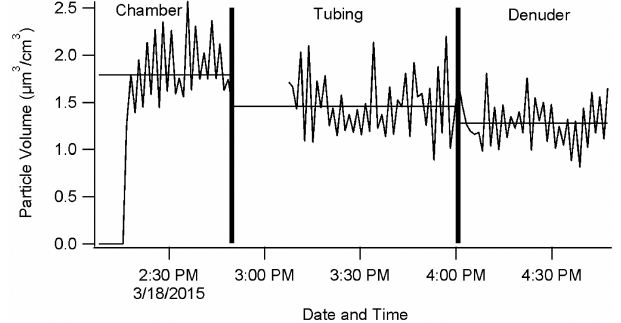
Figure 7. SEMS-measured particle volume vs. time to test denuder efficiency. From 02:15 (local time) to 03:00 the SEMS was measur- ing directly from the chamber. From 03:00 to 04:00 the SEMS was measuring particles from the TD-CRDS tubing (only internal tub- ing to the inlet system) without the denuder. From 04:00 to 05:00 the SEMS measured through the TD-CRDS tubing and the denuder. The horizontal lines represent the average particle volume over the sampling period. The missing data were due to room air entering the lines while the SEMS was detached from the chamber and reat- tached to the TD-CRDS